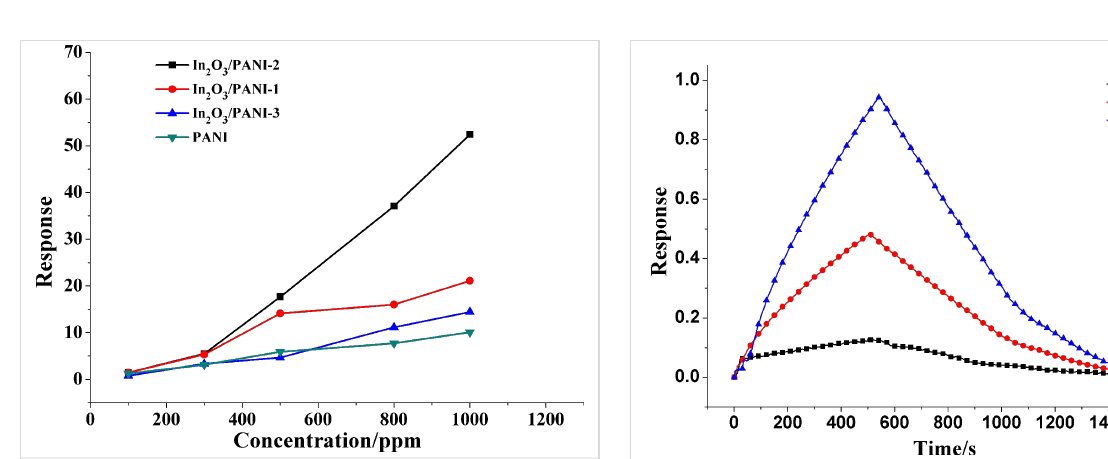
PANI (emeraldine salt) based sensors exhibited a great selec- tivity to NH 3